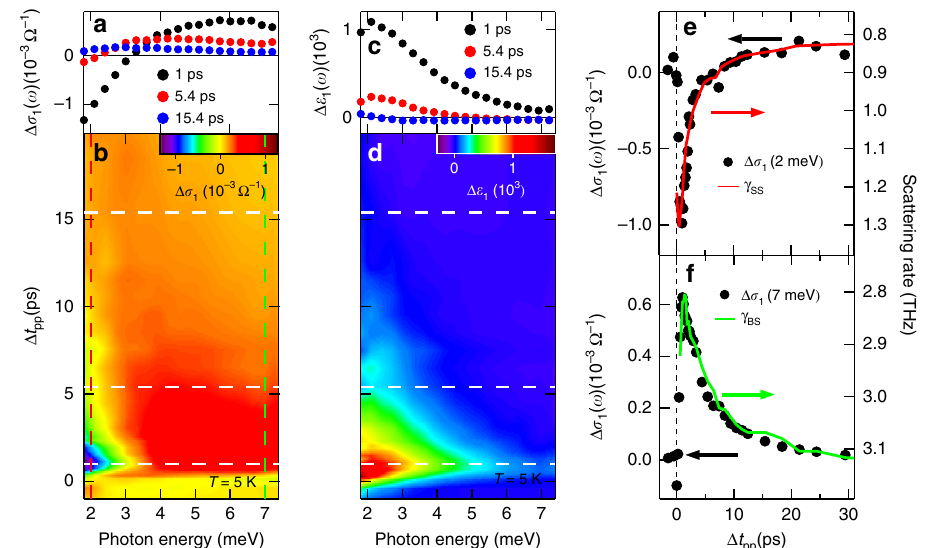
Fig. 2 Frequency-dependent dynamics of THz spectra at low temperature. Pump-induced THz spectra of a , b Δ σ 1 ( ω ) and c , d Δ ε 1 ( ω ) after 248 meV (5 μ m) photoexcitation with fl uence 12 μ J cm − 2 at T = 5 K as a function of pump-probe delay Δ t pp . a and c show the THz spectra from three cut positions from the corresponding 2D plots of b and d , respectively, at Δ t pp = 1, 5.4, and 15.4 ps, as indicated by the white-dashed lines. e THz conductivity at 2 meV, i.e., Δ σ Δ t 1 (2 meV) (black dots, left axis), as a function of pp , from the frequency-cut position in b as indicated by the red-dashed line. The scattering rate of the surface state γ SS (red curve, right axis) obtained from theoretical fi tting using Eq. 1 is plotted together to compare relaxation dynamics. f Similar to e , THz conductivity at 7 meV, Δ σ 1 (7 meV) (black dots, left axis) and the scattering rate of bulk state γ BS (green curve, right axis) are plotted. Δ σ 1 (7 meV) is from the frequency-cut position in b as indicated by the green-dashed line. As shown clearly, the relaxation dynamics of the surface (bulk) scattering rate matches with that of THz conductivity at 2 meV (7 meV) very well. This frequency-dependent THz relaxation dynamics indicates surface (bulk) state is more sensitive to low (high) THz